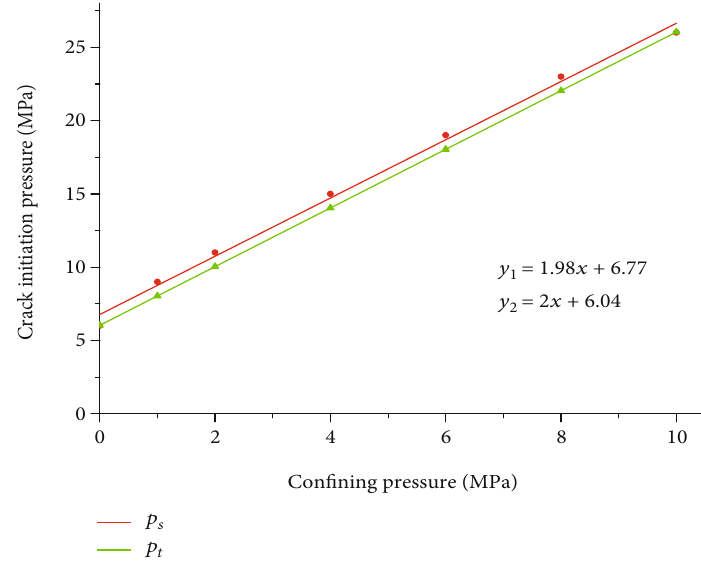
Figure 9: The linear relationship between crack initiation pressure and con fi ning